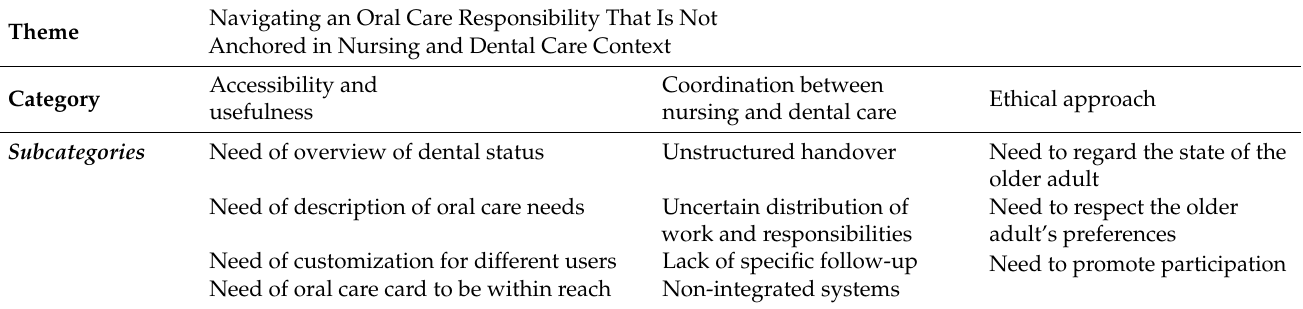
Table 3. Overview of the results in theme, categories, and